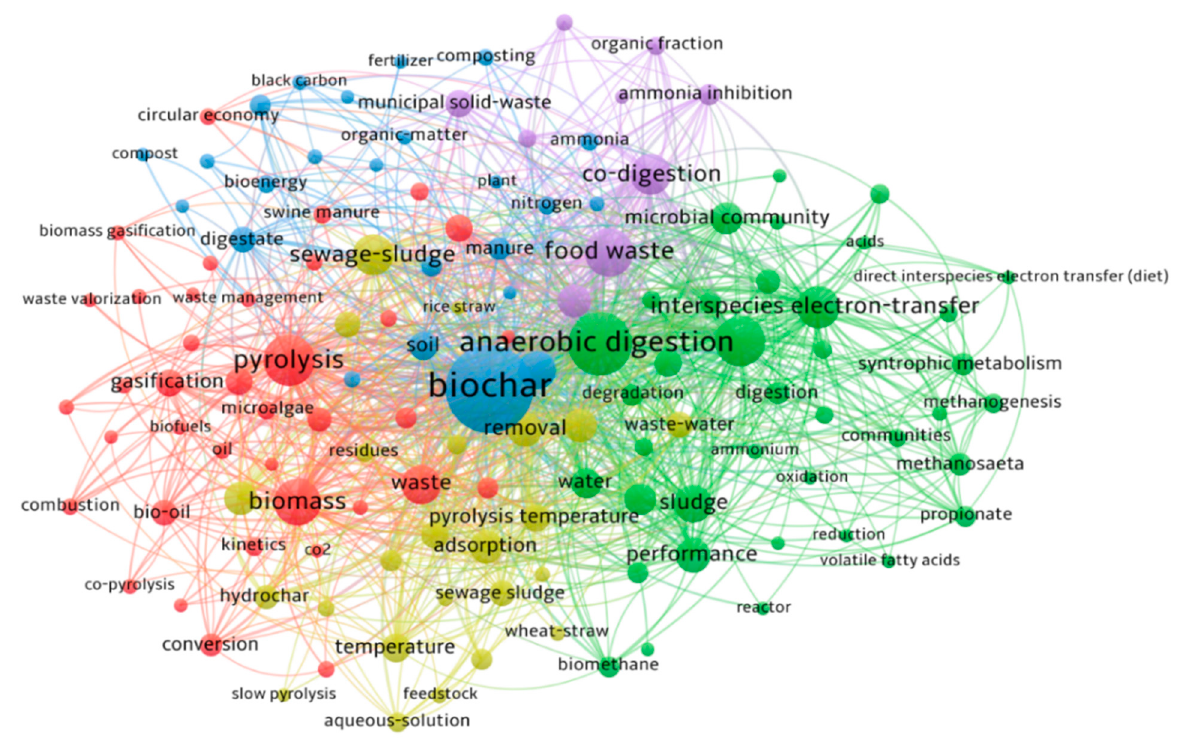
Figure 1. Network visualization of terms associated with anaerobic digestion and biochar.